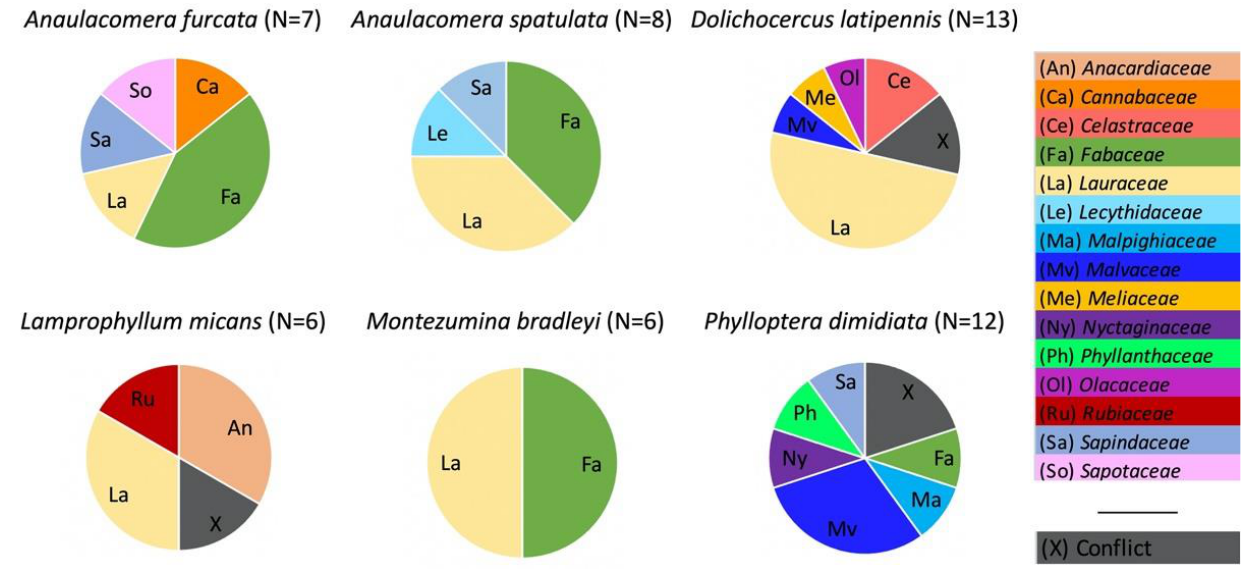
Figure 1. Plant families recovered from the stomach contents of six common katydid species on Barro Colorado Island, Panama. “Conflict” indicates that different primer sets show different plant species identifications for a given individual katydid.